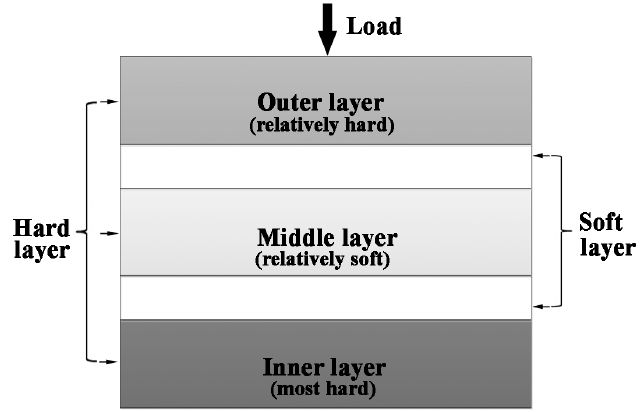
Figure 2. Diagrammatic sketch of bionic coupling impact resistance model.